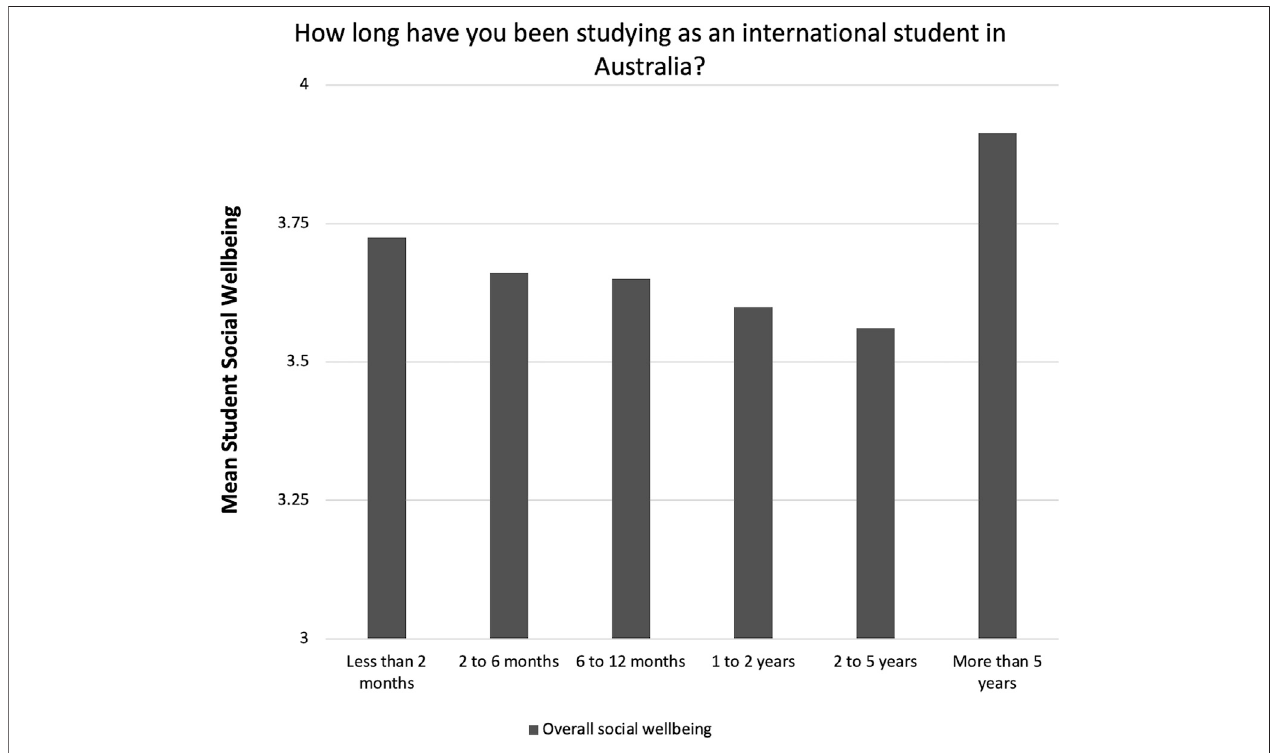
FIGURE 2 | Social wellbeing for different time spent in